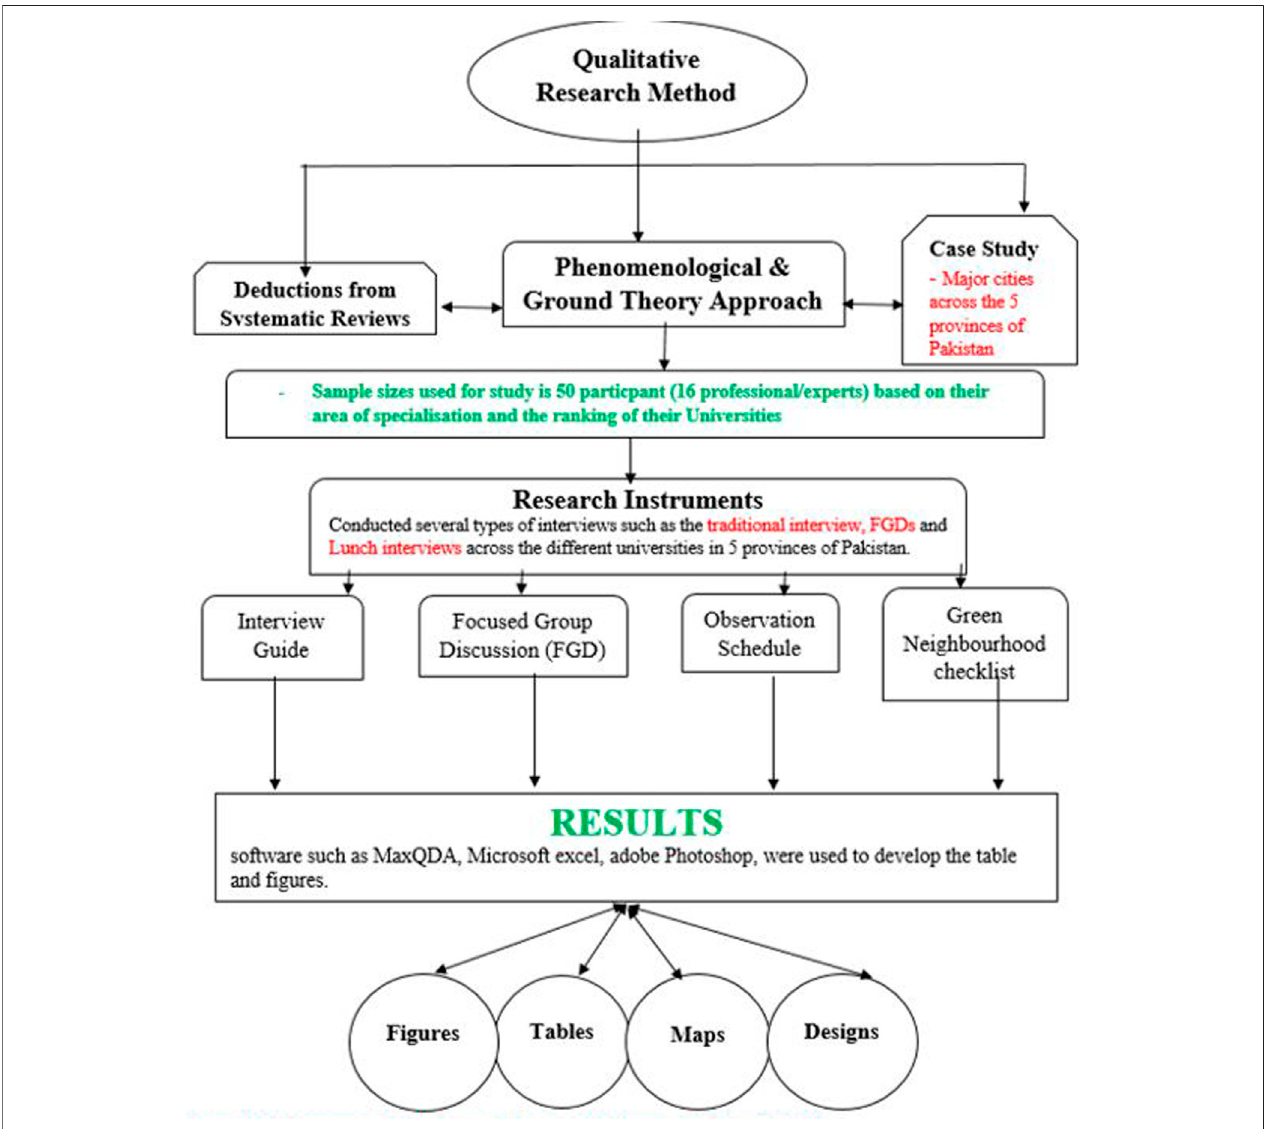
FIGURE 1 | Structure of the research method, source: Authors, 2021.